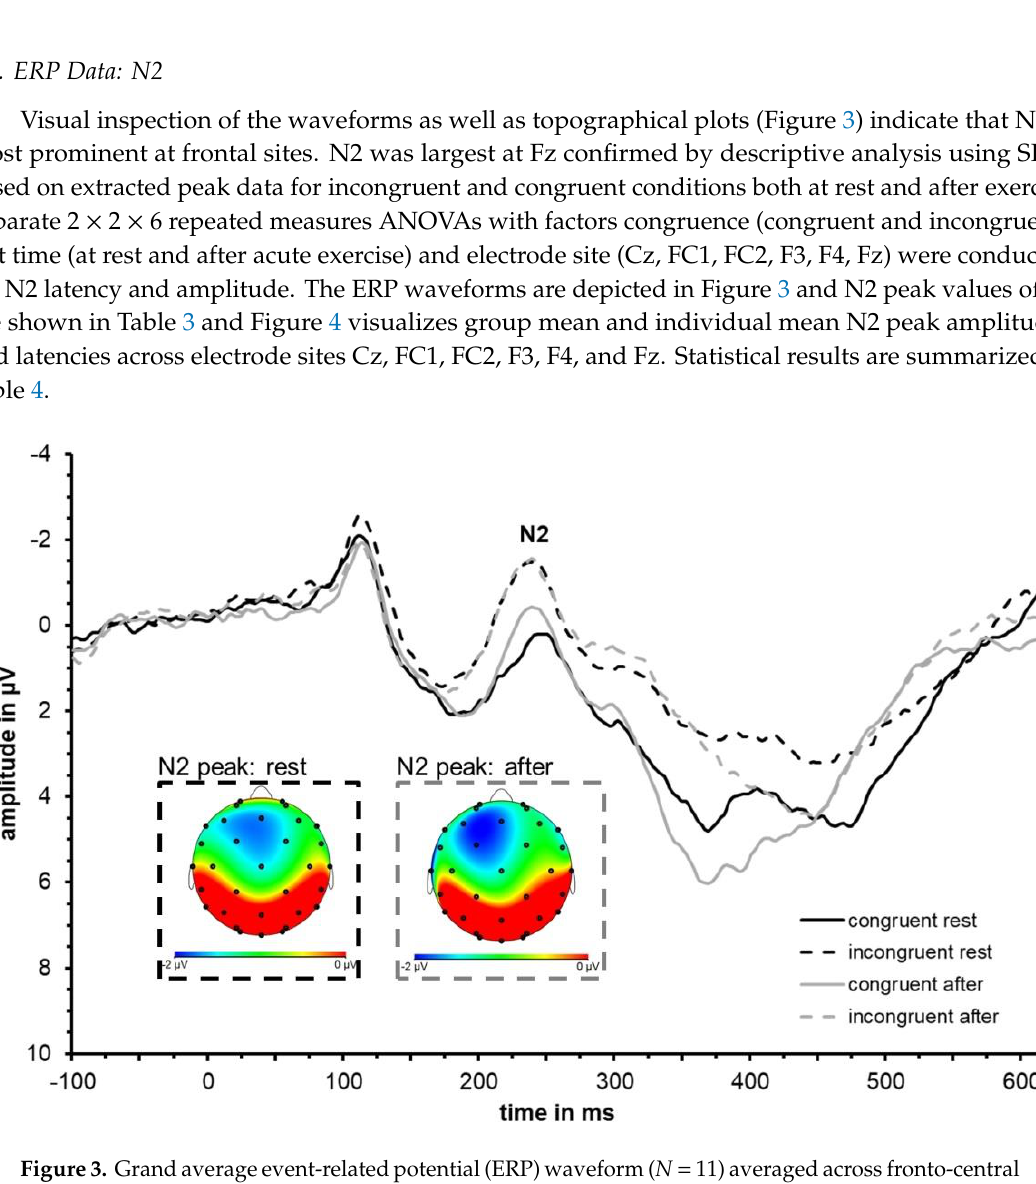
Figure 3. Grand average event-related potential (ERP) waveform ( N = 11) averaged across fronto-central electrode sites (F3, Fz, F4, FC1, FC2, Cz) depicting the neural responses (in particular the N2) to congruent (solid) and incongruent (dashed) trials at rest (black) and immediately after an acute bout of moderate-intensity exercise (grey). Topographical distributions at the time of N2 peak are shown for the incongruent condition at rest (dashed, black frame) and after exercise (dashed, grey frame).